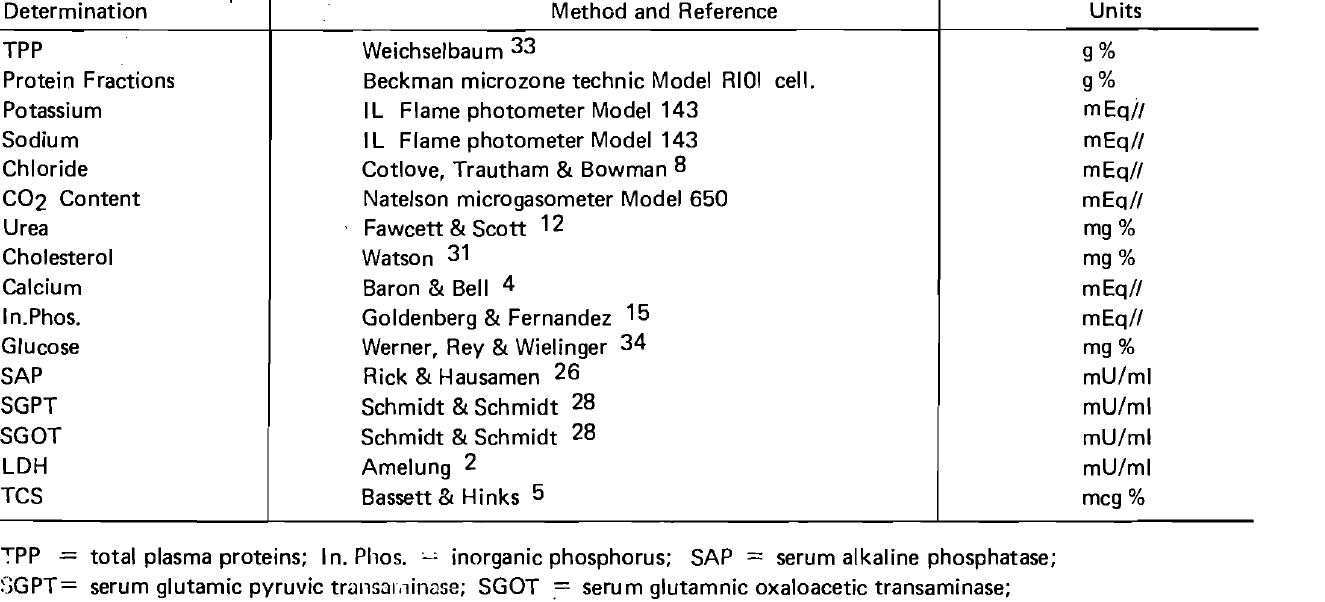
ANALYTICAL METHODS EMPLOYED FOR BLOOD CHEMICAL DETERMINATIONS Determination